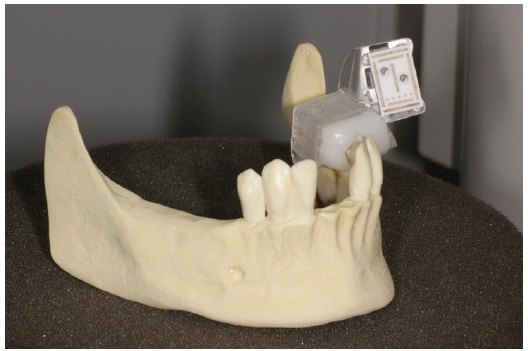
Figure 2. Plastic model with fixed marker, in this example a model from Group A.